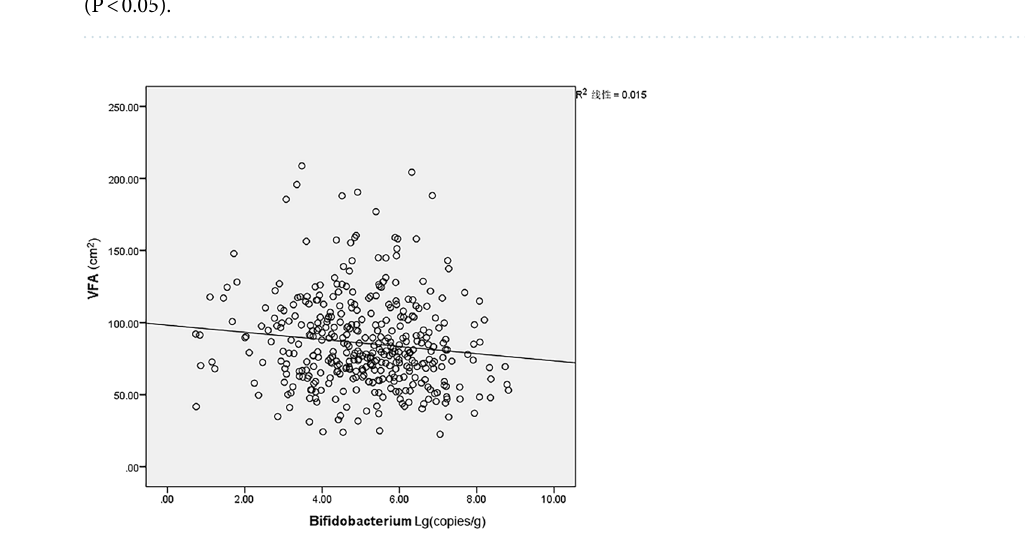
Figure 2. Correlation between Bifidobacterium and